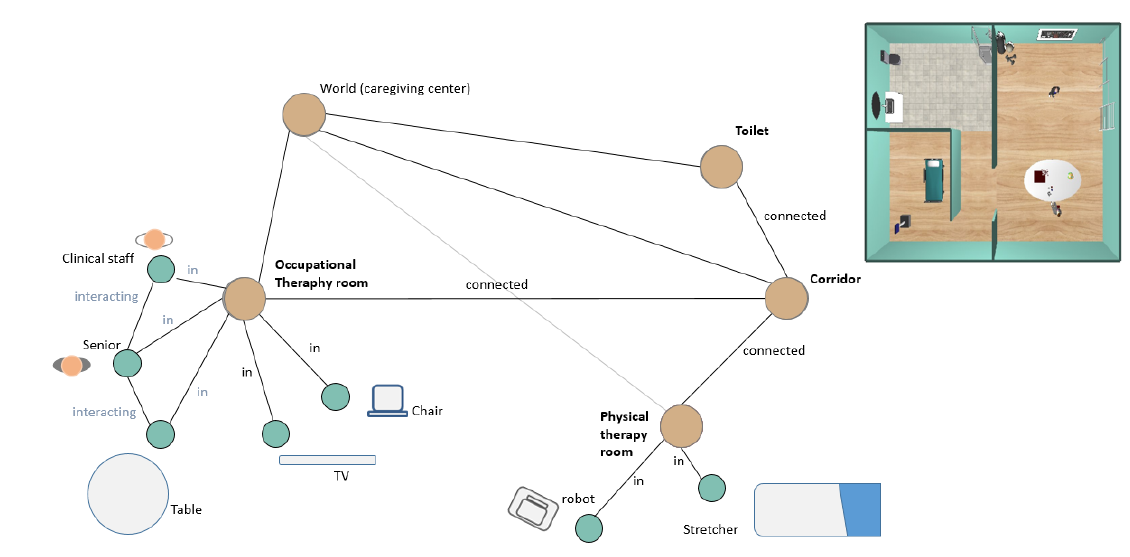
Figure 7. Example of the shared representation (DSR) in CORTEX. The simulated caregiving center is shown on the top right. The scenario is composed of four rooms, with objects and people within